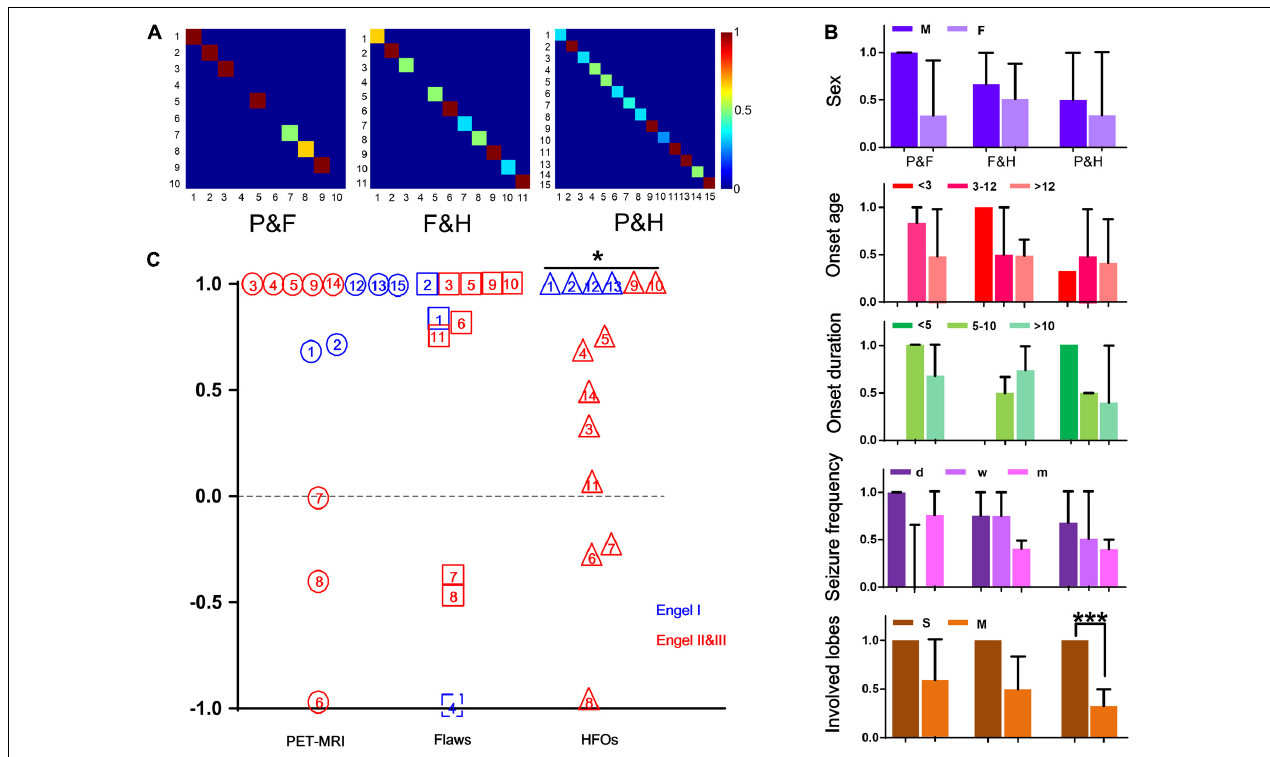
FIGURE 2 | Consistency of the three methods. (A) The three images show the consistency of PET-MRI and FLAWS (P&F), FLAWS, and HFOs (F&H), PET-MRI and HFOs (P&H), and colors closer to red indicate better consistency. (B) The consistencies in different conditions are shown here. Different colors represent different groups (sex, onset age, onset duration, seizure frequency, and involved lobe). *** p = 0.001. (C) RatioChann(ev) for each patient obtained using the three methods are listed in this figure. PET-MRI, FLAWS, and HFOs are listed from left to right and are indicated by circles, boxes, and triangles, respectively. The numbers written in the different patterns indicate different patients. Additionally, patients’ outcomes are marked in different colors. For patient #4, the FLAWS examination did not identify an abnormality, and the ratio of removal was unable to be determined; therefore, we marked it with an imaginary line. For patient #10, electrodes were not implanted in all suspicious areas marked by PET-MRI, and thus, the patient was excluded from the comparison. * p < 0.05.